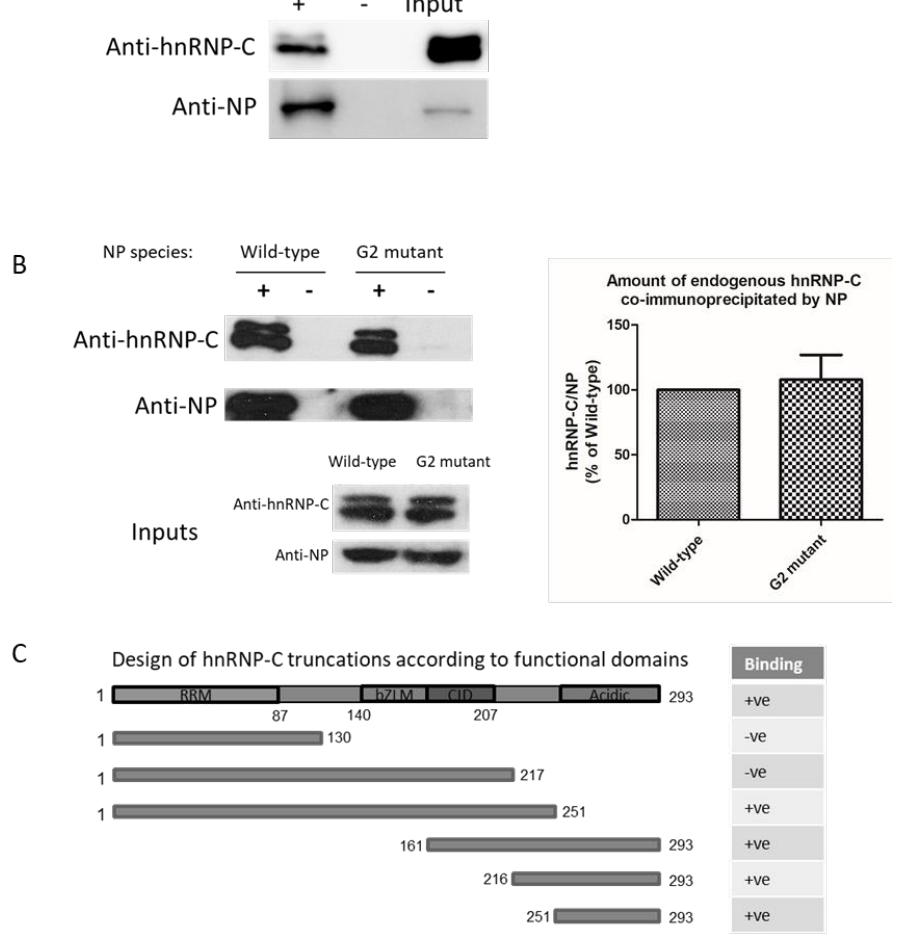
Figure 2. ( A ) myc-tagged H5 NP was used to co-immunoprecipitate endogenous hnRNP-C in the